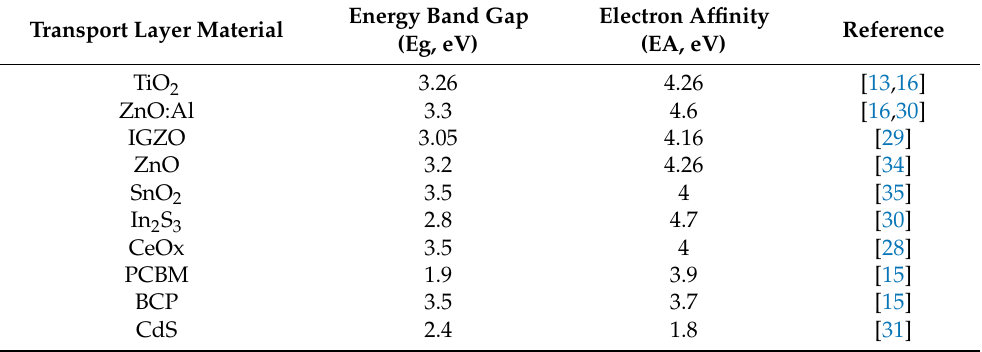
Table 3. Energy bandgap and electron affinity for commonly reported electron transport layer materi-